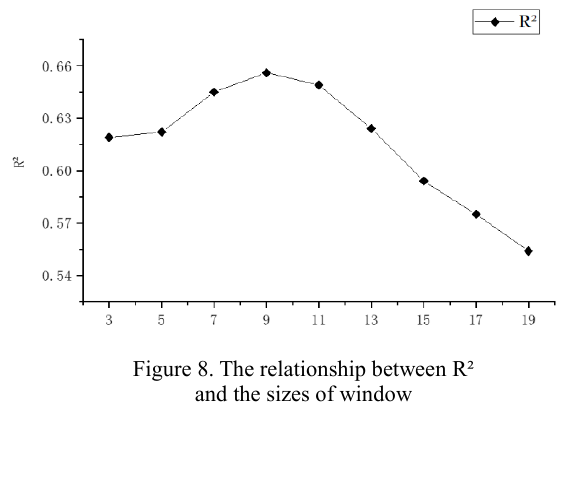
Figure 7. Validation of estimated forest height with different window size